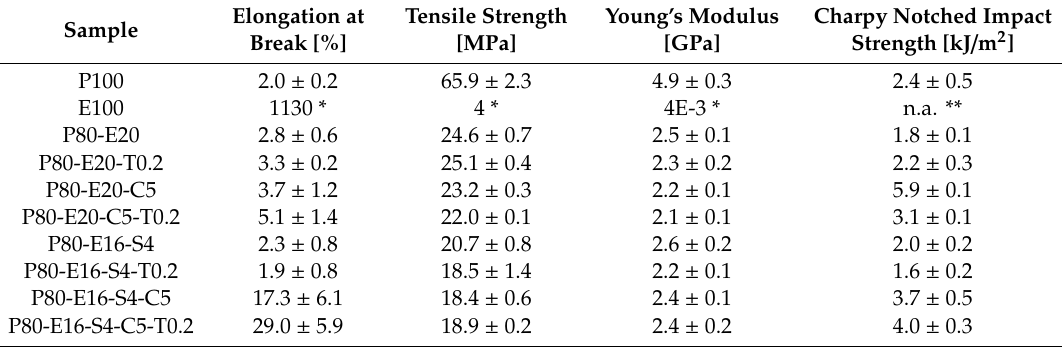
Figure 14. Tensile tests of the corresponding samples. ( a ) Samples without SBO and ( b ) samples with SBO. Table 4. Mechanical Properties of the Corresponding Samples from Tensile and Charpy Impact